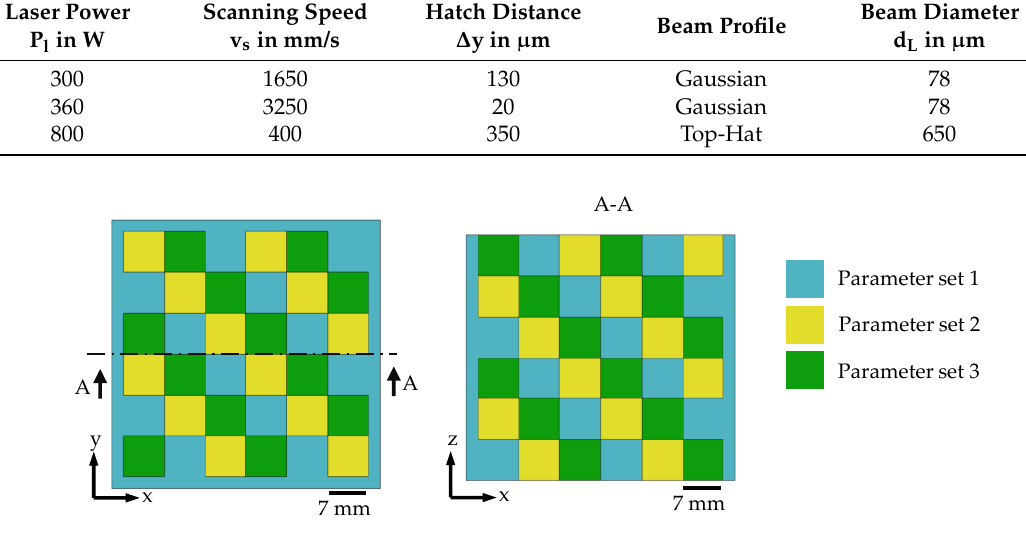
Figure 3. Arrangement of the parameters within the large cube.